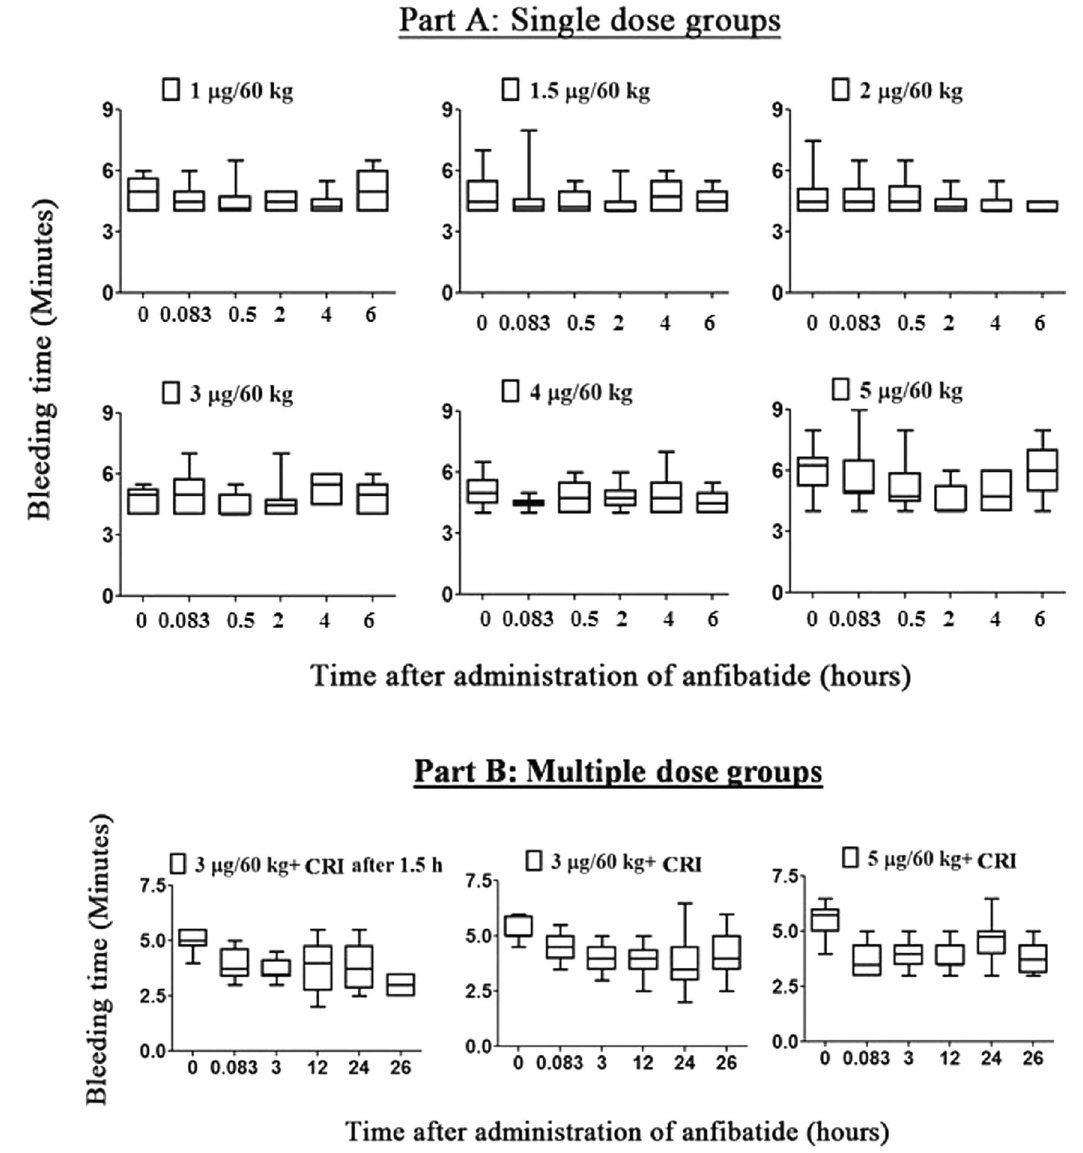
Figure 8. Anfibatide did not significantly prolong bleeding time. Bleeding time was monitored in both single ( A , N = 8–9/each) and multiple dose groups ( B , N = 6–12/each), and each bleeding time measured was determined to the nearest 30 s. Majority of the subjects in the single dose groups (except 5 subjects) had a lower bound close to 4 min, while those in the multiple dose groups had a lower bound ranging from 2 to 4 min. None of the subjects in the single and multiple dose groups had a bleeding time of more than 9 min. Bleeding time of all subjects was within the normal range of 2 to 9 min. CRI: constant rate